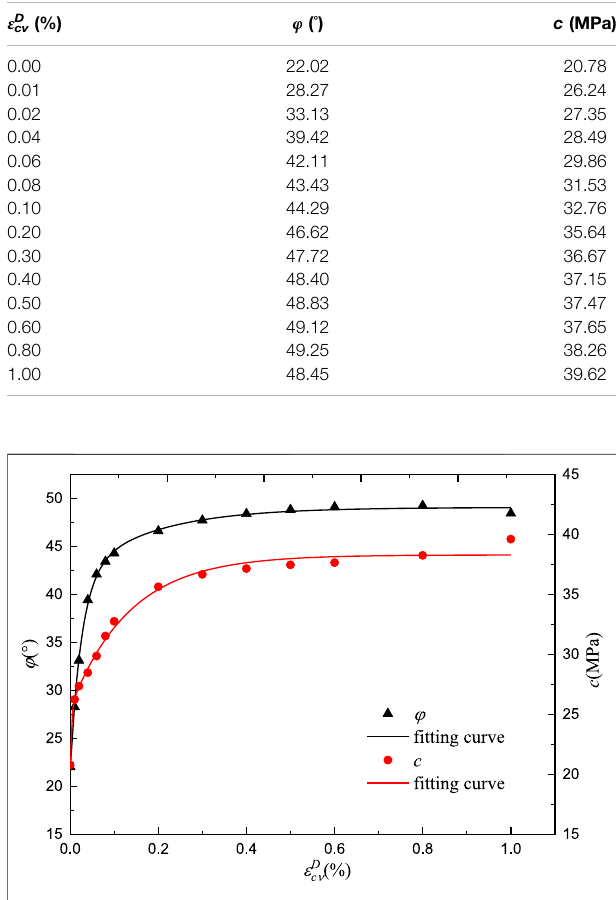
TABLE 4 | φ and c values at various ε D cv values.